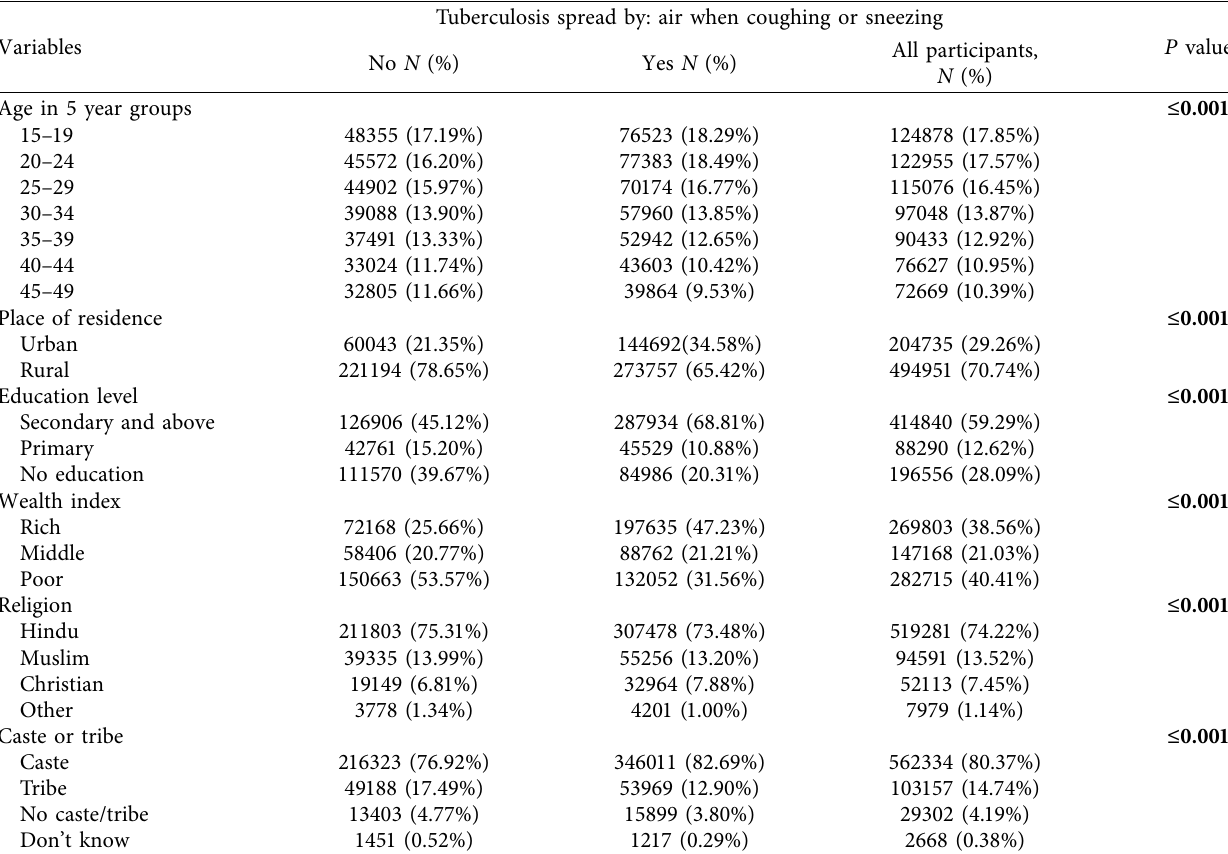
Table 3: Association between knowledge regarding transmission of tuberculosis and sociodemographic characteristics of study participants ( N � 699,686).